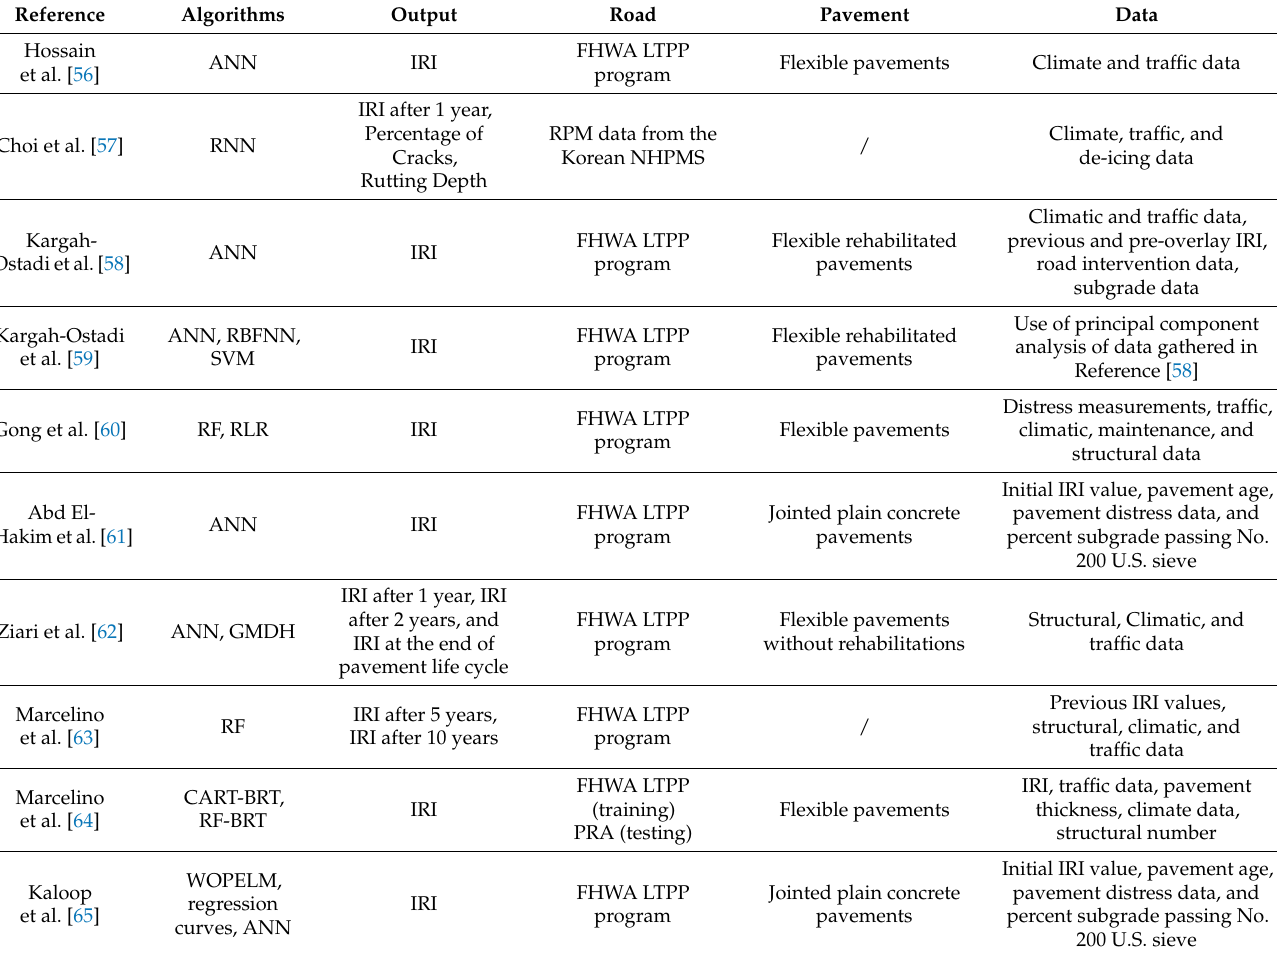
Table 1. Machine and deep learning algorithms in road pavement